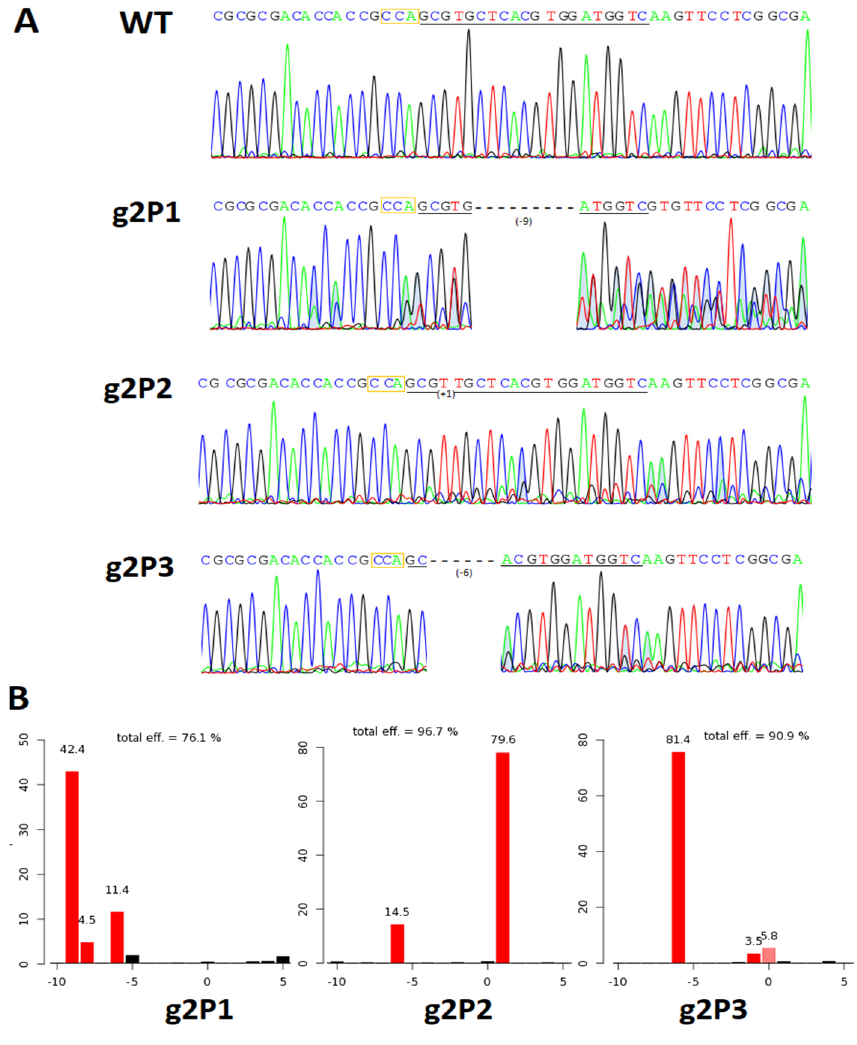
Figure 2. Example data set of chromatograms ( A ) and TIDE-generated indel spectra ( B ) of the most frequent edits in wheat sub-genome A target site in g2P1, g2P2 and g2P3 cell lines. ( A ): indel size in bp indicated by a number in brackets; protospacer underlined, PAM marked with the yellow frame; WT—wild type. ( B ): editing efficiency (%) indicated on y axis, indel size indicated on x axis. For more data please see the supplementary material Figure